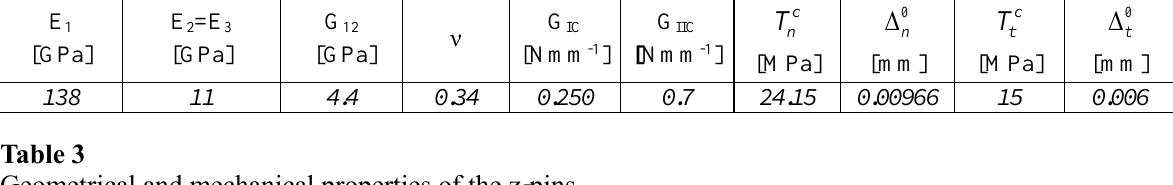
Fig. 6. DCB scheme reinforced with z-pins (a); MMB scheme reinforced with z-pins (b). Mechanical and interface properties of the laminate.